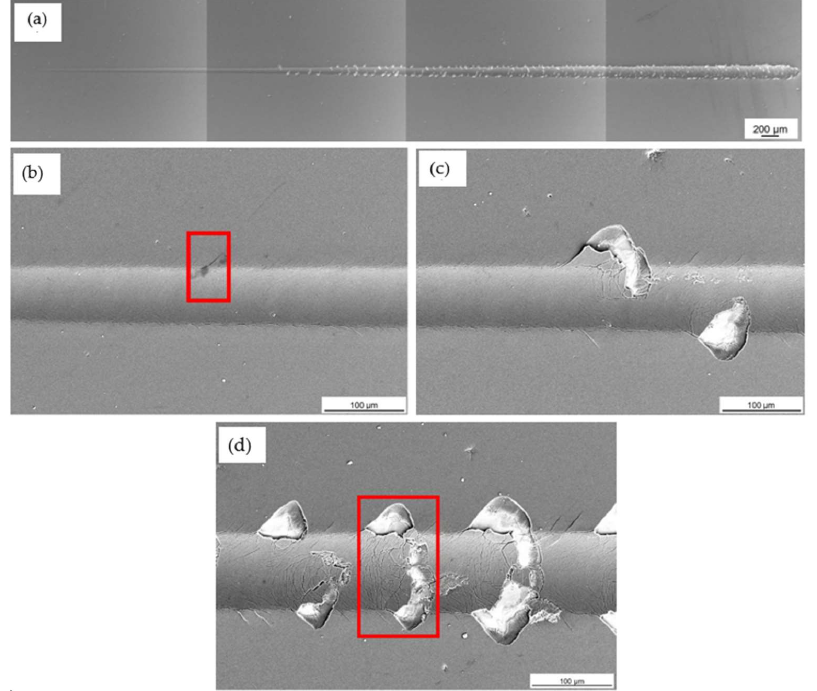
Figure 14. SEM topographical images of the wear scar morphology on the printed coated 316L SS: ( a ) Whole length of the wear scar ( b ) Red box showing location of L C1 ( c ) Location of L C2 and ( d ) Red box showing location of L C3 .